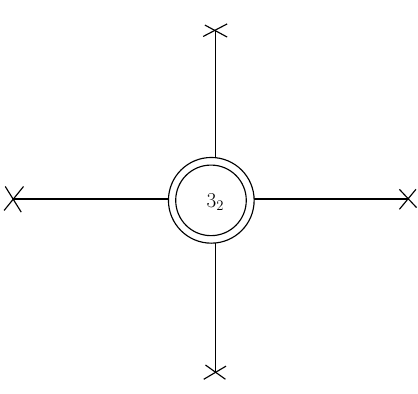
Figure 7 . Model of four copies of T x with SU(3) = Z 3 gauged at level two, dual to T x